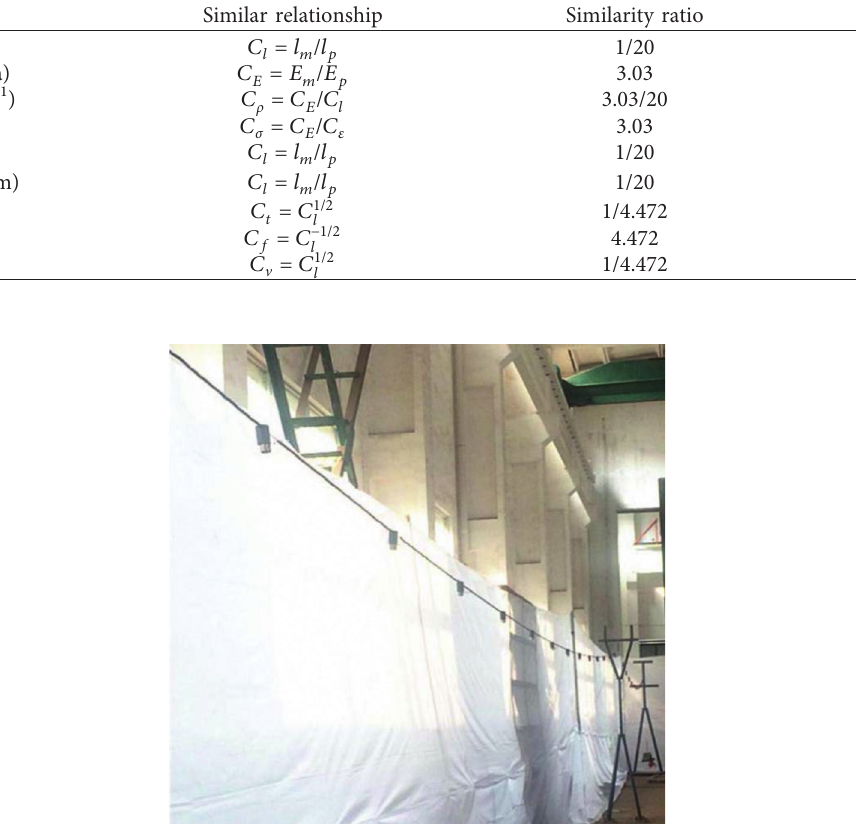
Figure 1: The experimental model of tower-line system.